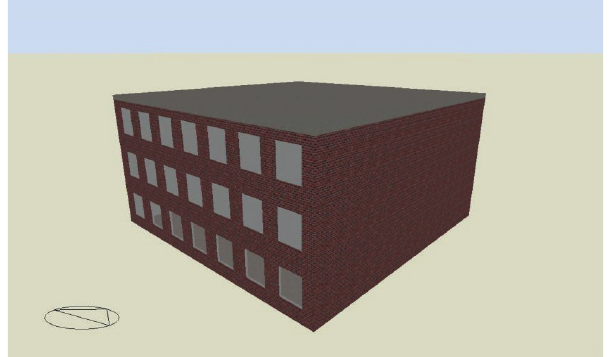
Figure 2: Building